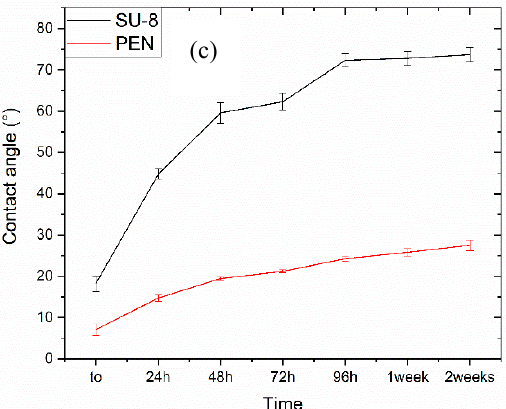
Figure 4. Images of PEN ( a ) and SU-8 ( b ) aging contact angle test and relative measurements at t 0 , 24 h, 48 h, 72 h, 96 h, one and two weeks ( c ).